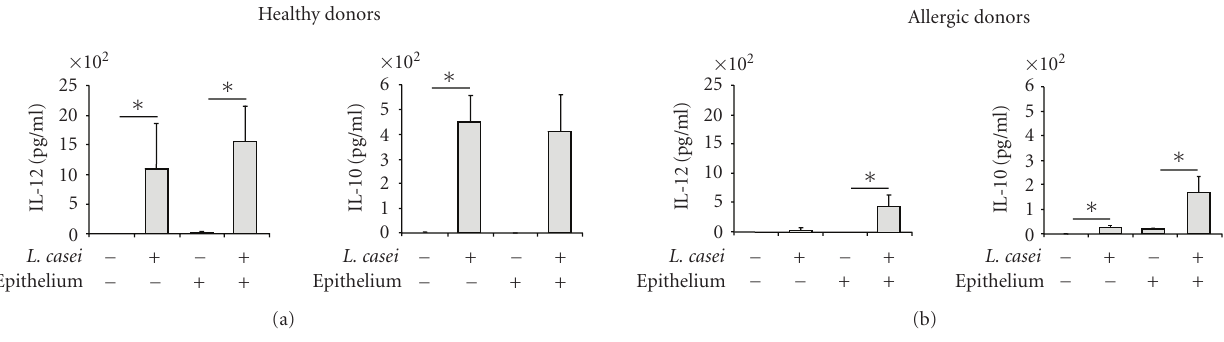
Figure 4: L. casei-stimulated DC produce IL-12 and IL-10 . Monocytes-derived DC from healthy (a) and allergic (b) donors were pulsed or not for 48hours with L. casei through an intestinal epithelial layer or not. Supernatants were collected and the amounts of IL-10 and IL-12 were measured by specific ELISA. Results are expressed as mean ± SEM ( n = 5 for allergic donors and n = 5 healthy donors). ∗ P < .